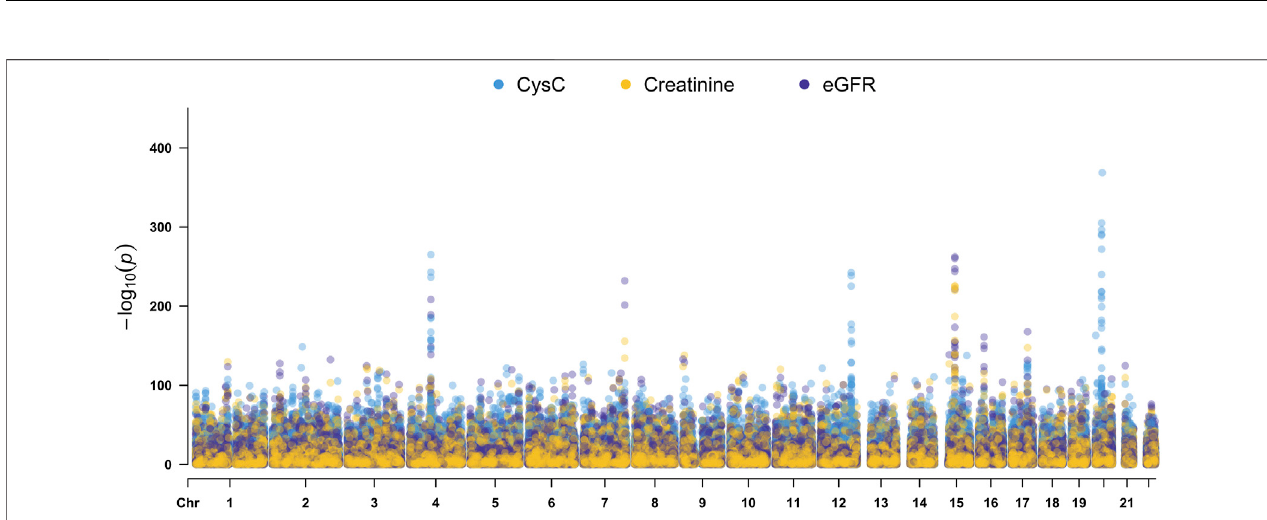
FIGURE 2 | Manhattan Plots for cystatin C, creatinine, and eGFR genome wide association studies. Variants are positioned according to the GRCh37 genome reference sequence.